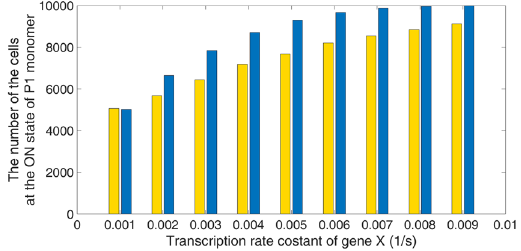
Figure 5. The influence of inhibitor on bimodal distribution. The y-axis is the number of cells at the ON state of P1 monomer. We examined the influence of inhibitor on bimodal distribution for two scenarios. For both scenarios, the transcription rate constant of Y is of nominal value and that of X is specified in the x-axis where 0.001 is the nominal value. The yellow bar indicates the circumstance with the assumption that the only consumption of complexes X and Y comes from dissociation. Namely, the yellow bar tells us how the change of stochasticity alone affects the bimodal distribution. In comparison to the blue bar which accounts for both the change of stochasticity and the consumption of P2 trimer, it concludes that the change of the stochasticity is also the main cause of pushing cells to the specific state.